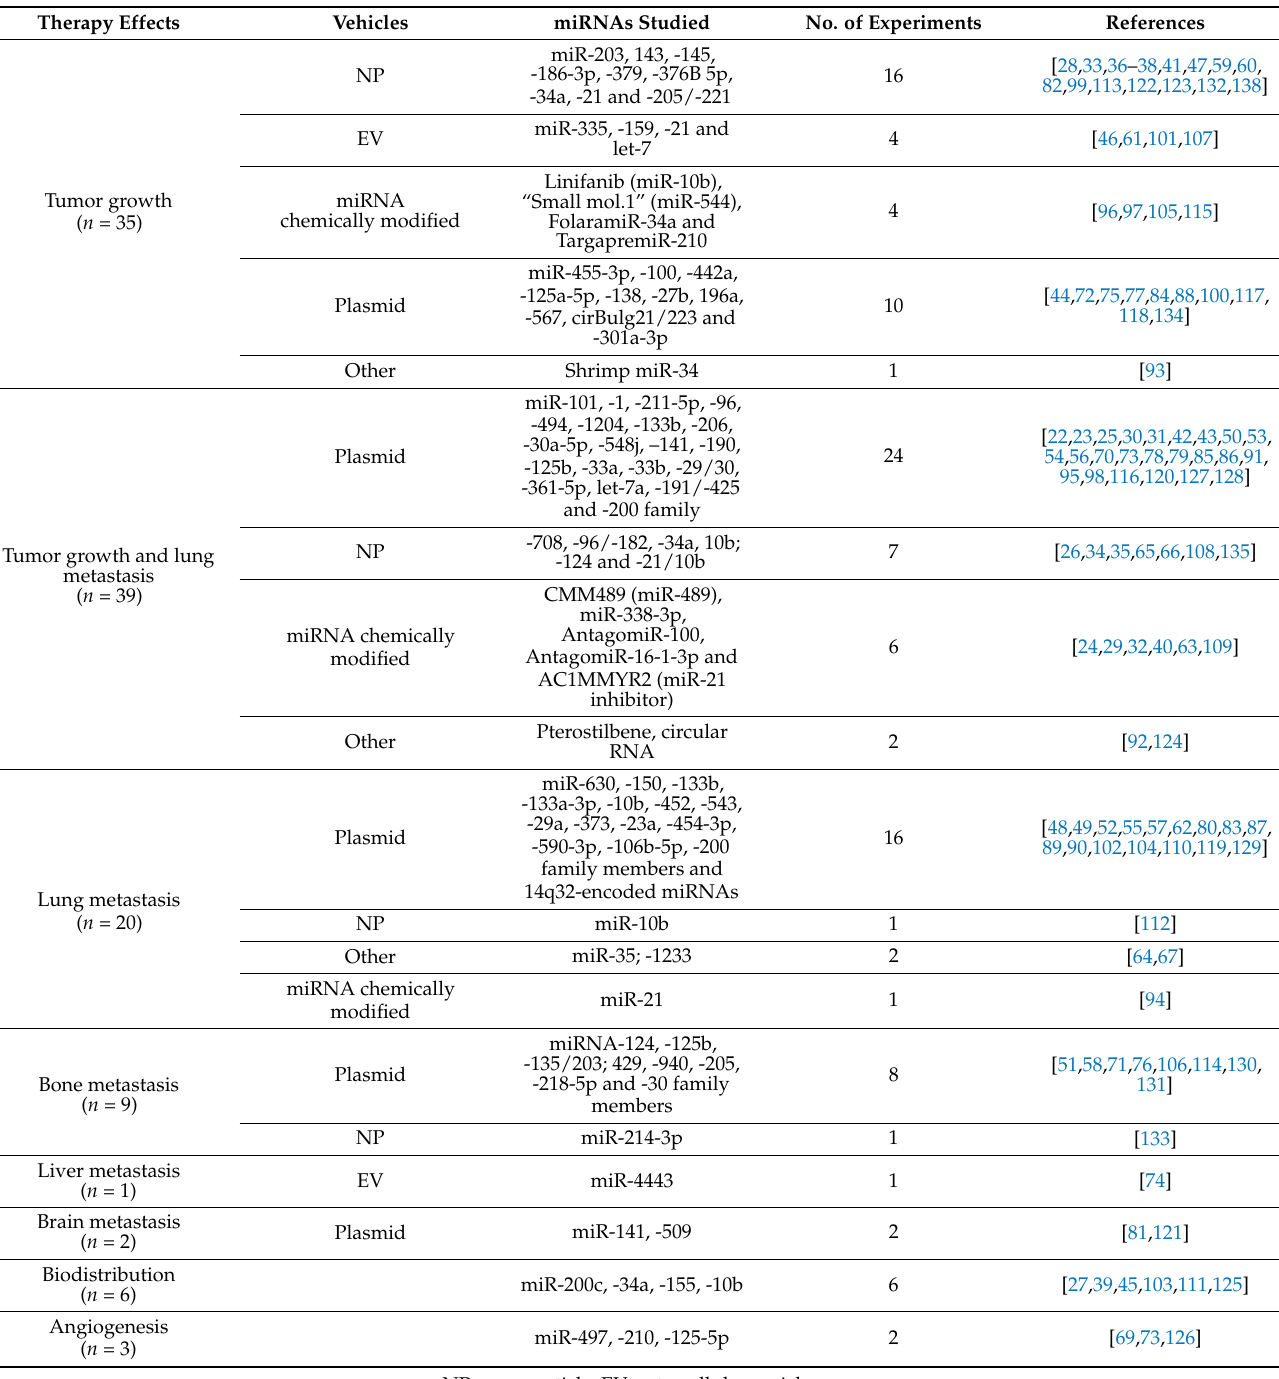
Table 5. Therapy effects in mice models following miRNA